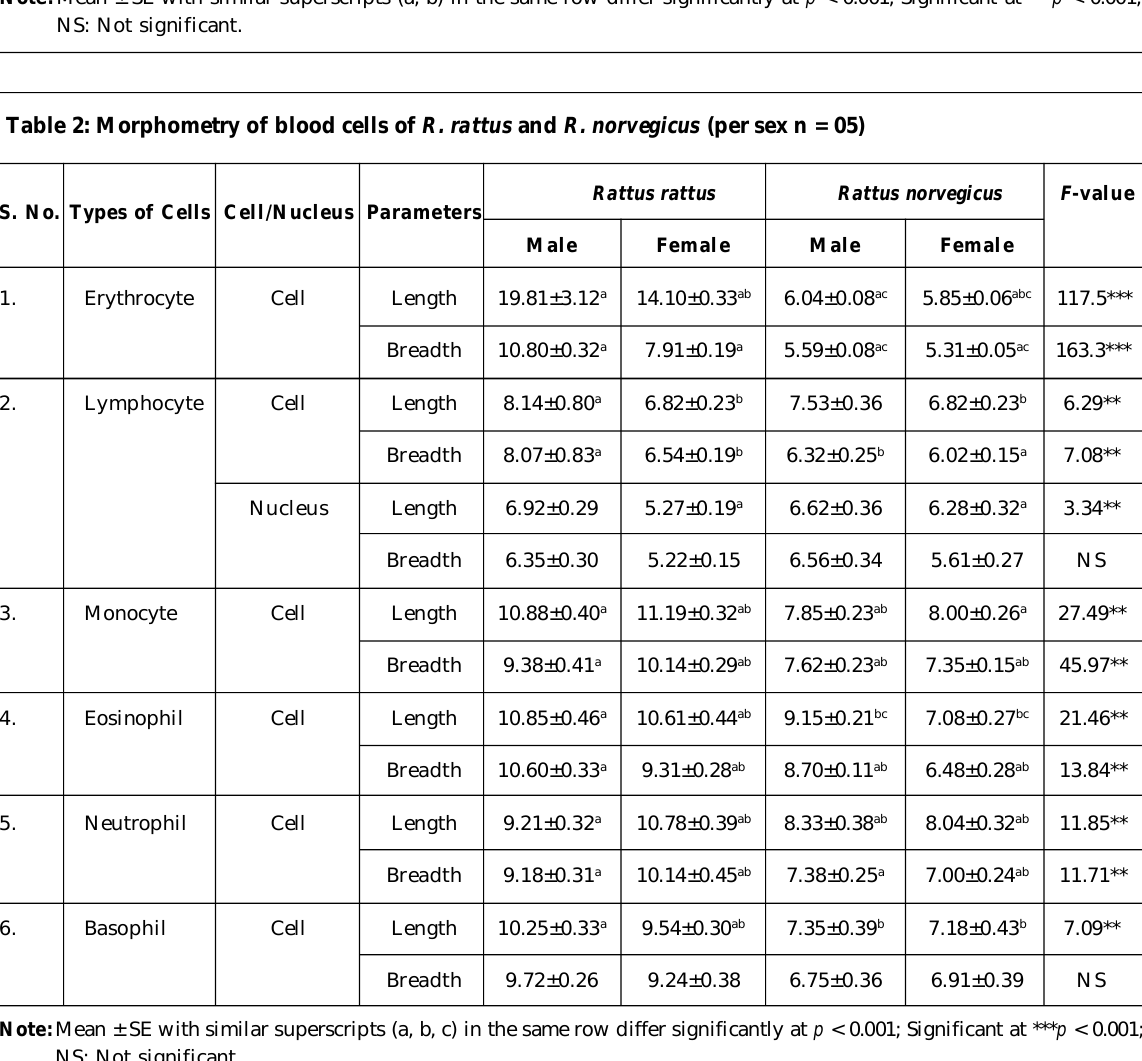
Table 2: Morphometry of blood cells of R. rattus and R. norvegicus (per sex n = 05)